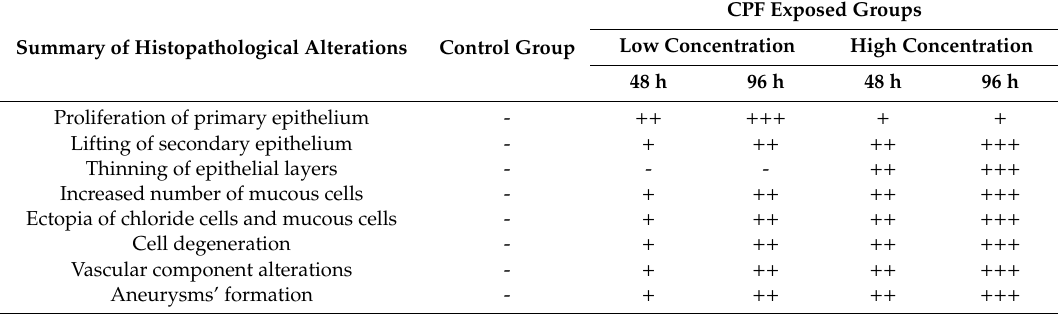
Table 2. Semi-quantitative comparison of histological alterations in T. pavo gills between the groups exposed to CPF and the control